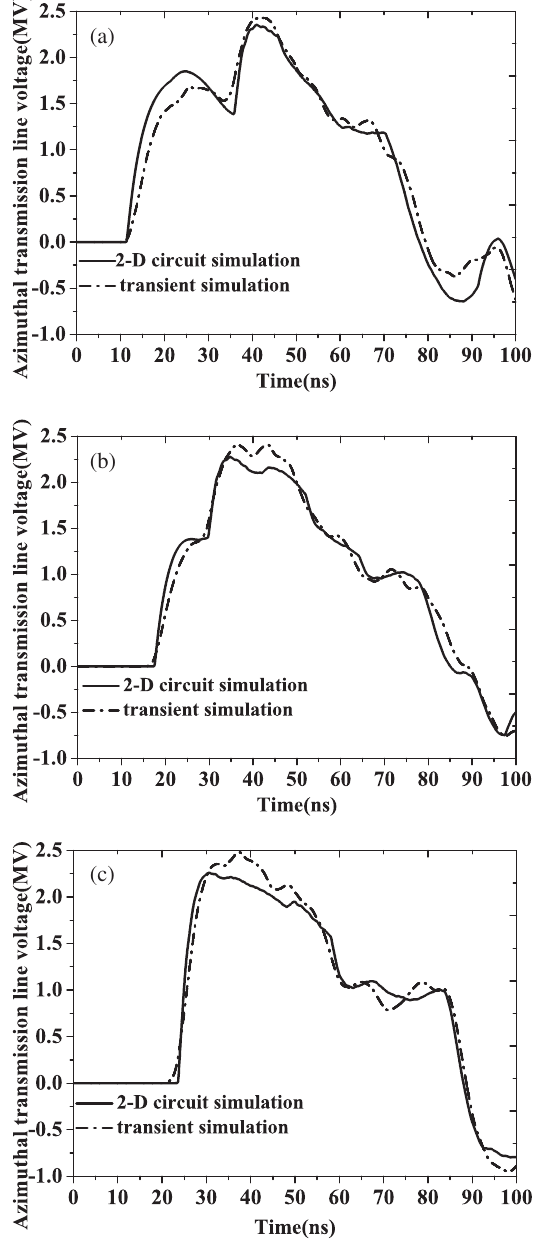
FIG. 6. Azimuthal transmission line voltage waveforms ob- tained by 2D circuit simulation (black solid line) and transient electromagneticsimulation (blackdash-dottedline)at(a) 0degree, (b) 90 degrees and (c) 180